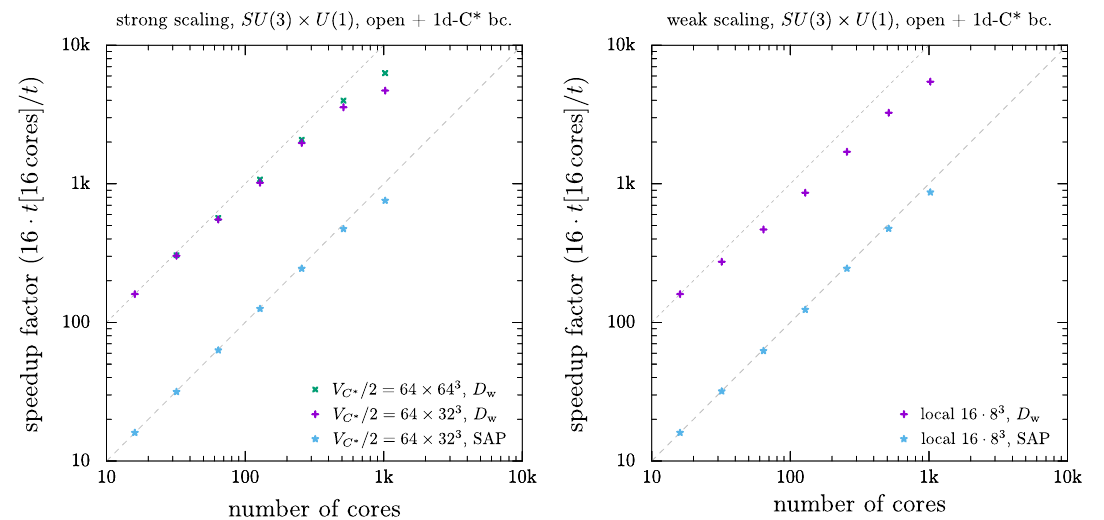
Fig. 3 Results for strong (left) and weak (right) scaling of the appli- cation of the Dirac operator and SAP preconditioner as explained in the text. The speedup factors for the Dirac operator are multiplied by a